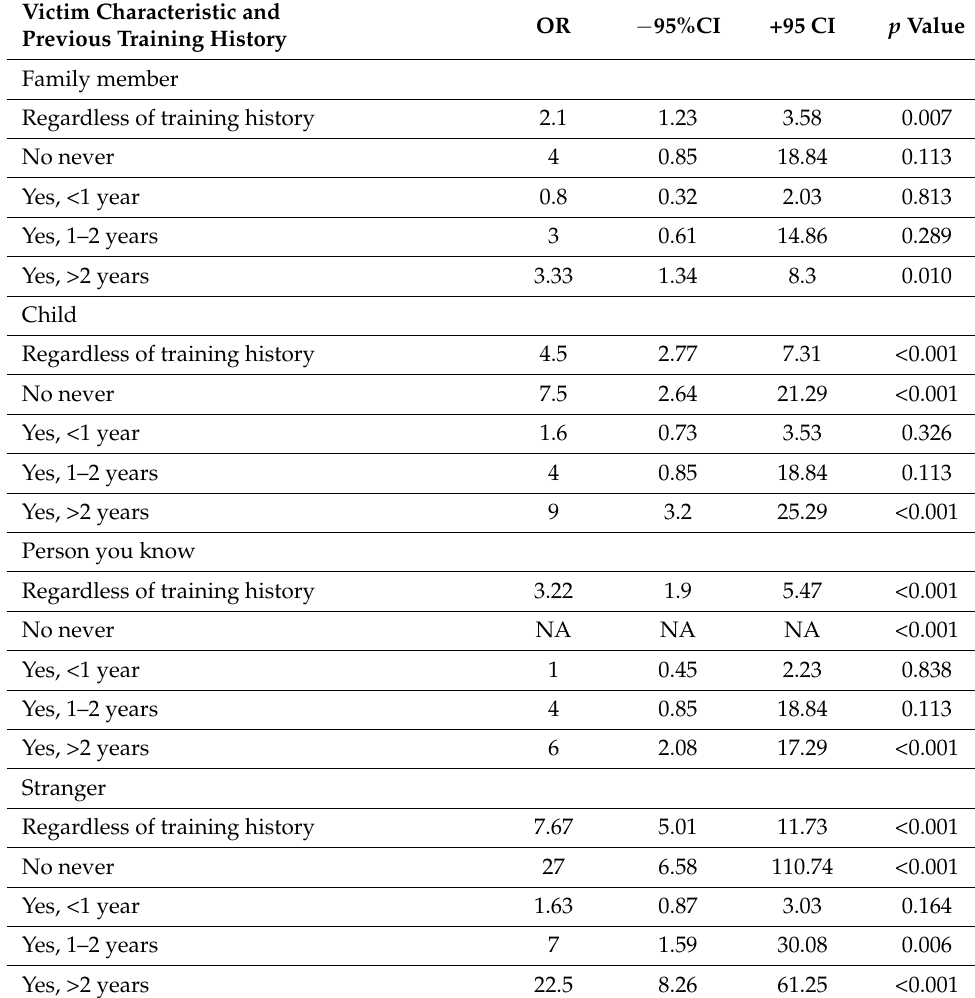
Table 4. The probability of changing the decision to undertake CPR in individual victims after current